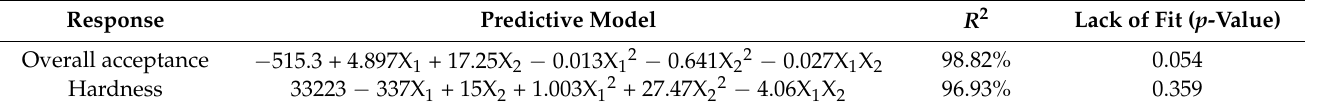
Table 3. Response surface predictive model of overall acceptance and hardness of braised mackerel with radish at different heating temperatures (X 1 ) and times (X 2 ).